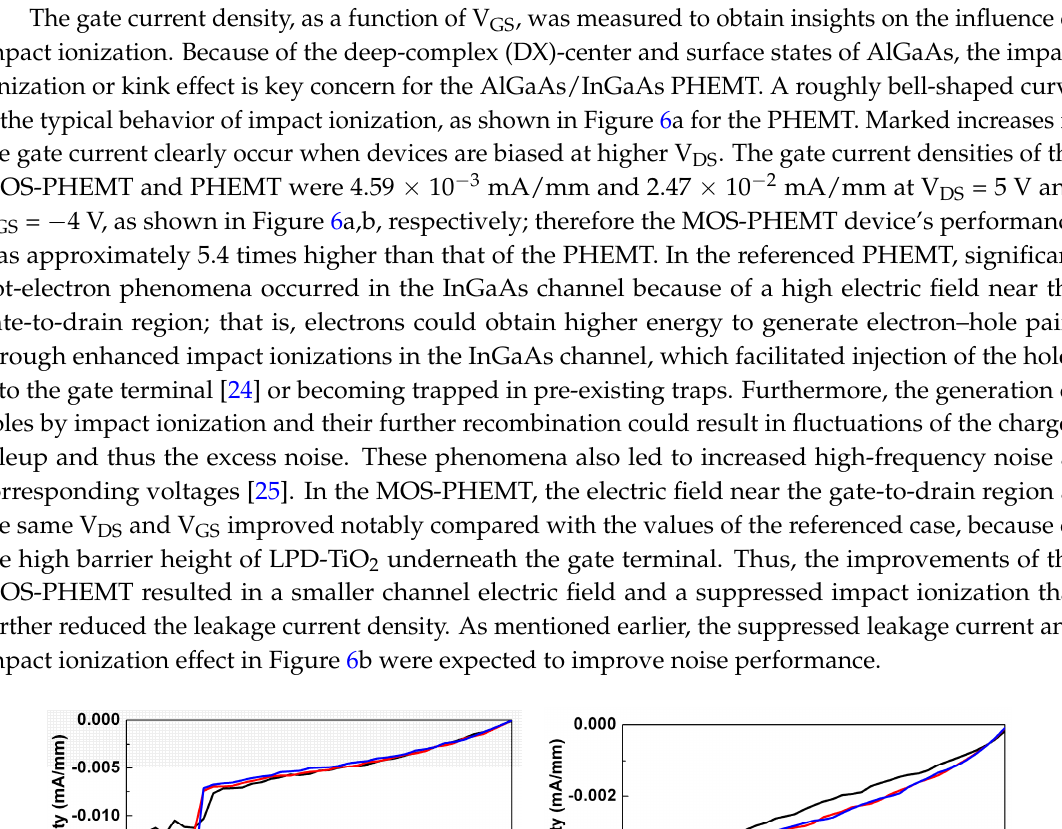
Figure 5. ( a ) Forward gate leakage current density; and ( b ) magnified section of reverse gate leakage current density of typical gate-to-drain diode characteristics for both devices.